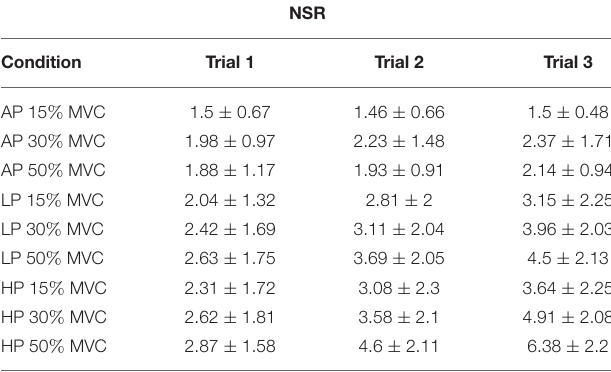
TABLE 2 | Reported discomfort.